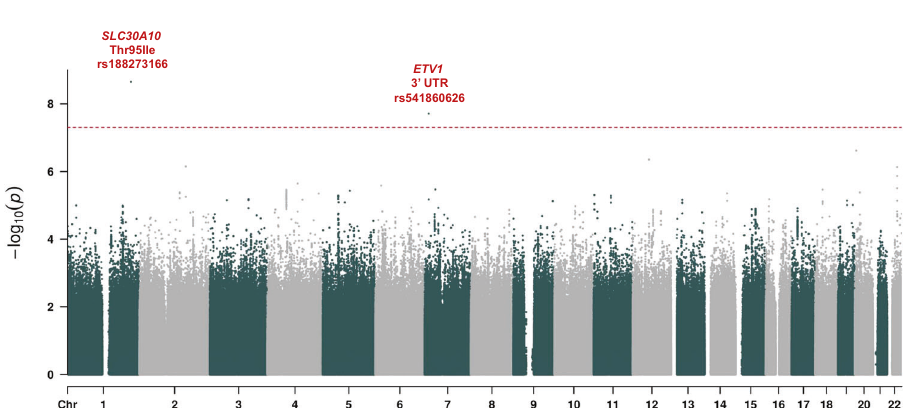
Fig. 5 GWAS of extrahepatic bile duct cancer. P values are from SAIGE in White British. Dashed line is genome-wide signi fi cance level of p = 5 × 10 − 8 . Source data for this fi gure are available from NHGRI-EBI GWAS catalog accession GCST90013662.